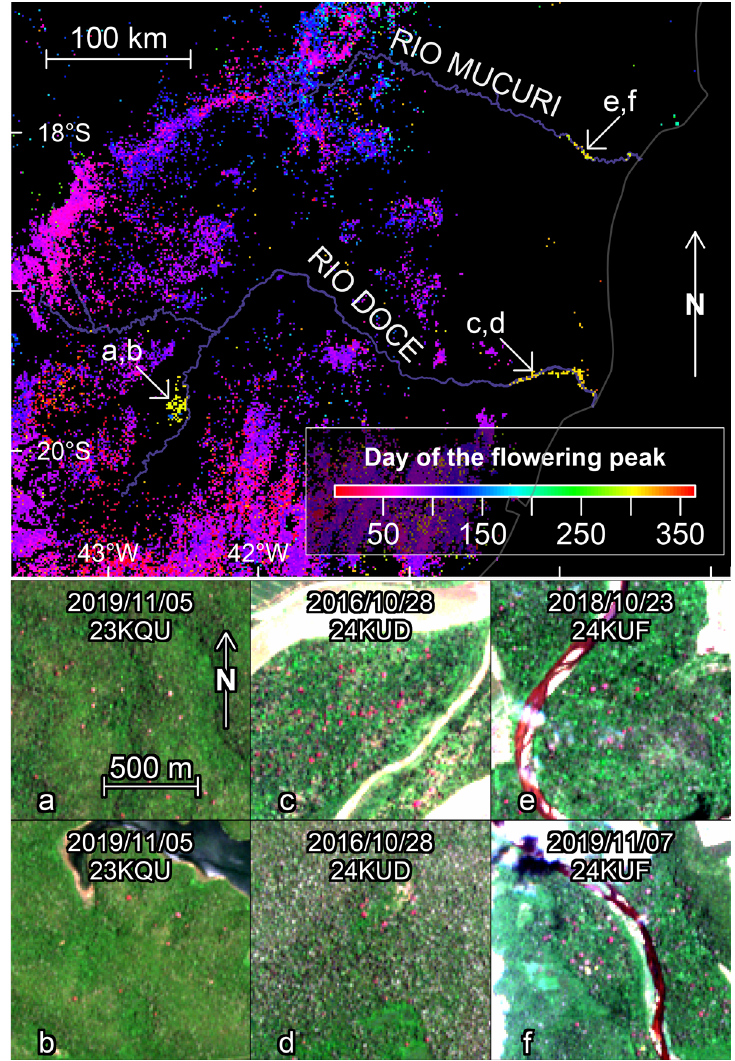
Figure 10. Geographical locations of the three isolated patches with trees of the genus Handroanthus flowering in late October/early November (from cluster 12) and Sentinel-2 image subsets of locations of the pink flowering trees in Rio Doce State Park ( a , b ) and along the Rio Doce ( c , d ) and Rio Mucuri rivers ( e , f